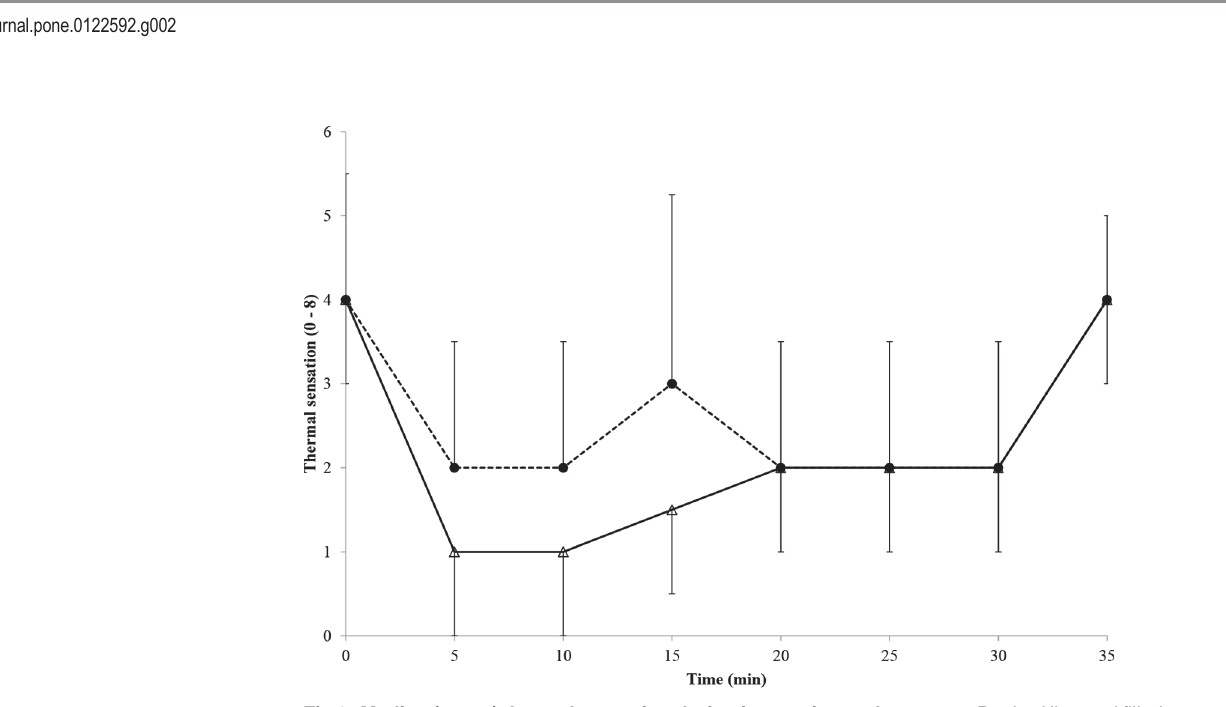
Fig 3. Median (range) thermal sensation during immersion and recovery. Dashed line and filled circles = 8°C trial; solid line and open triangles = 0°C trial.